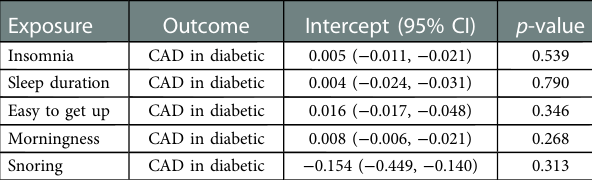
TABLE 2 MR-Egger regression intercept